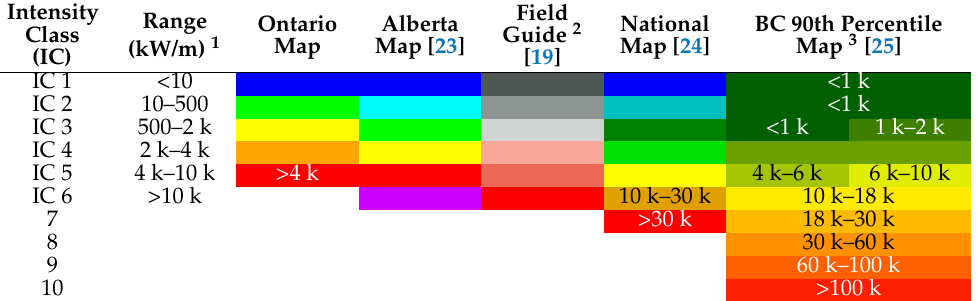
Table 2. Examples of the diverse classification of fire intensity and colouring used in Canada. The Ontario, Alberta and national schemes are used in daily maps. The British Columbia (BC) scheme is used in a static map of the 90th percentile of historical fire intensity. The Field Guide to the Fire Behaviour Prediction System (Field Guide) scheme is used in printed tables. Intensity classes IC 1–IC 6 are as defined in [19]; the higher classes are informal. The colours are